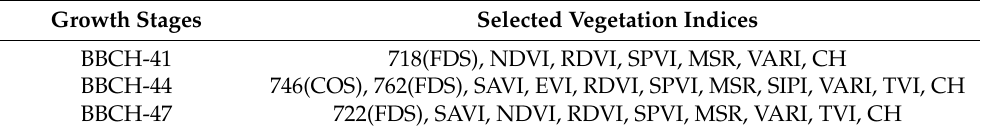
Table 8. Model factors involved after removing highly relevant variables for each growth stage. Growth Stages